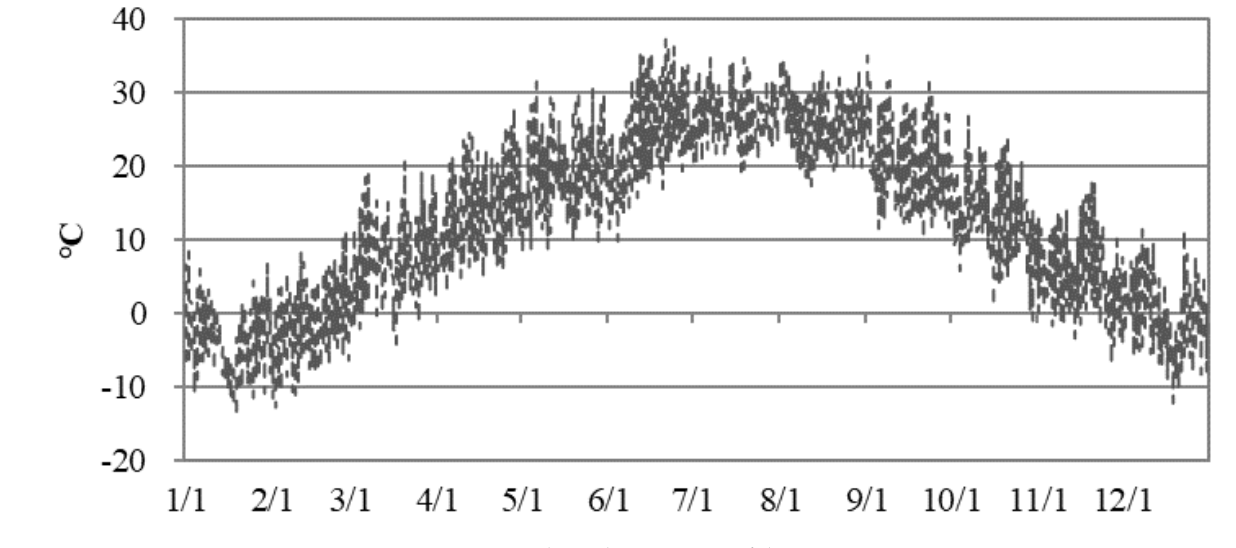
Figure A1. Meteorological parameters of the Beijing area. Table A1. Input parameters of the building model.